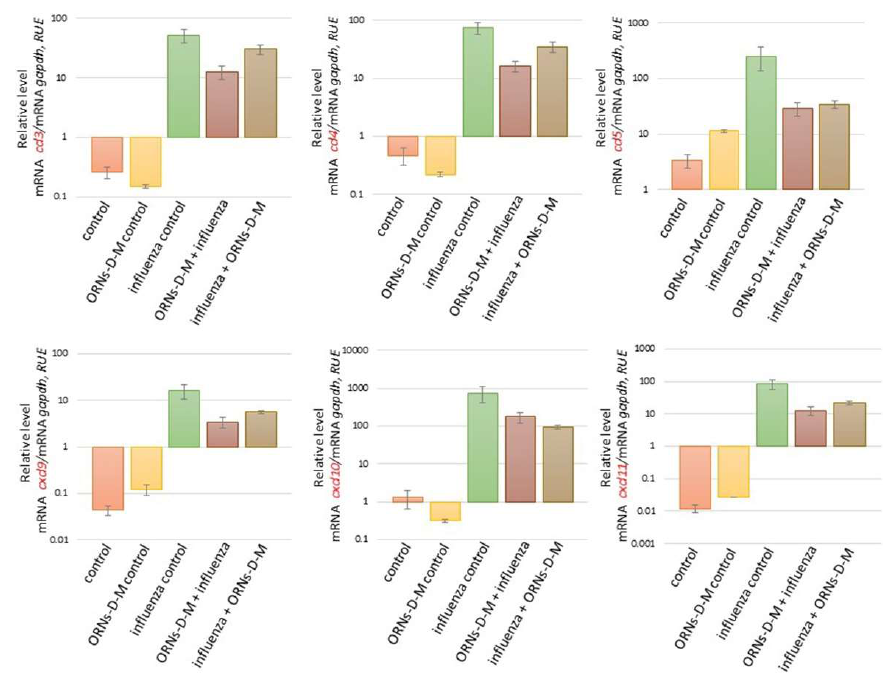
Figure 5. Impair the pro-inflammatory chemokines overexpression induced by the influenza virus A/Fort Monmouth/1/1947-mouse adapted (H1N1) owing to the ORNs- D -M in vivo. Before and after infection with the influenza virus FM147 (4.0 lg LD 50 ), the BALB/c mice were treated with ORNs- D -M. Total RNA from the mice lung was isolated and RT-qPCR was performed. Samples were normalized to gapdh as a control. RUE: relative units of expression. ORNs- D -M control—ORNs- D -M injection into healthy mice, influenza control—infection of mice with influenza virus, and ORNs- D -M + influenza—ORNs- D -M injection 24 h before infection with the influenza virus and prevention with ORNs- D -M, and influenza + ORNs- D -M—ORNs- D -M injection 24 h after infection with the influenza virus and treatment with ORNs- D -M. Data are shown as the mean ± SD for three independent experiments.